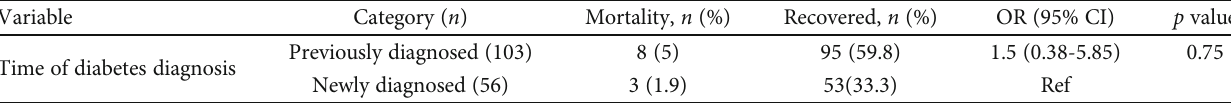
Table 4: Association between the time of diabetes onset and risk of mortality.